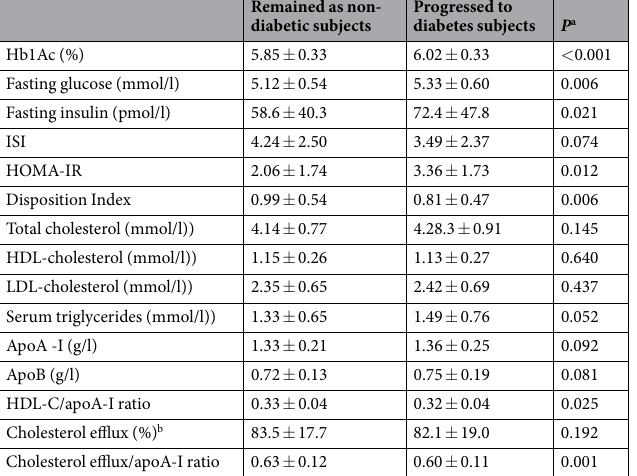
Table 2. Baseline glucose metabolism and lipid parameters of the study subjects by glycaemic status at the end of the follow-up period. Data are presented as mean ± SD. a P between groups analysed by univariate model adjusted by age, sex BMI and batch number (in cholesterol efflux and cholesterol efflux/apoA-I ratio). b Cholesterol efflux values are adjusted to the inter-assay control in each